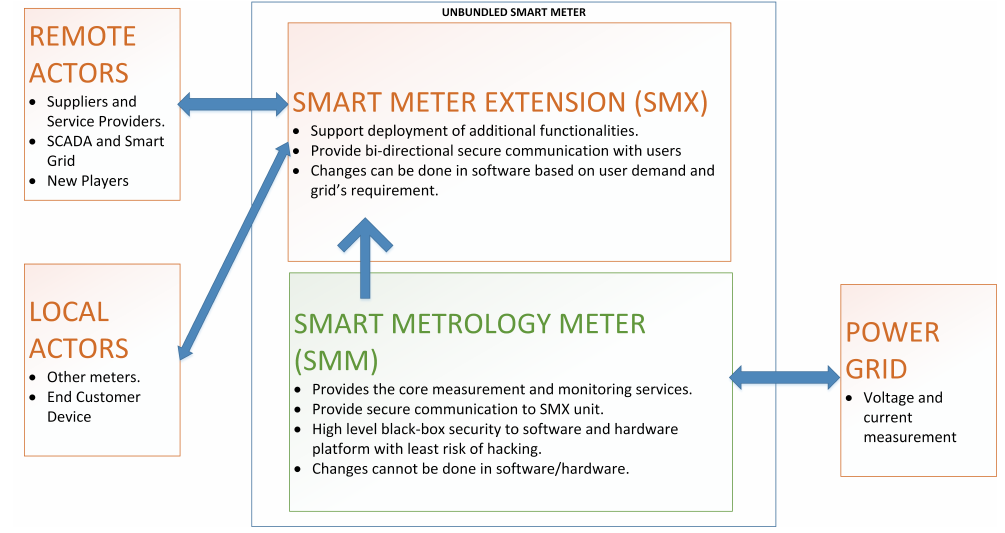
Figure 1. Unbundled Smart Meter